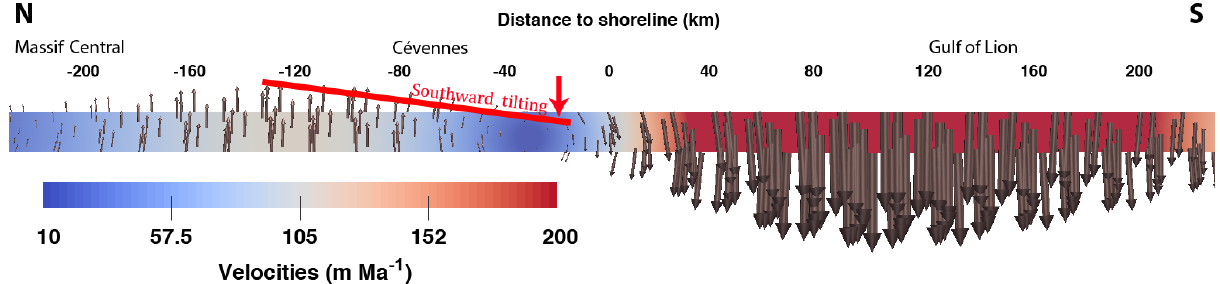
Figure 13. Modeling result for T e = 15km. Erosion–sedimentation rate profile is the same as in Fig. 6. Velocity field is shown using arrow for orientation; velocity magnitudes are quantified by the font color code. Black values on top are distance relative to the seashore (positive value landward and negative values seaward). Red line represents the southward, modeled tilting due to differential